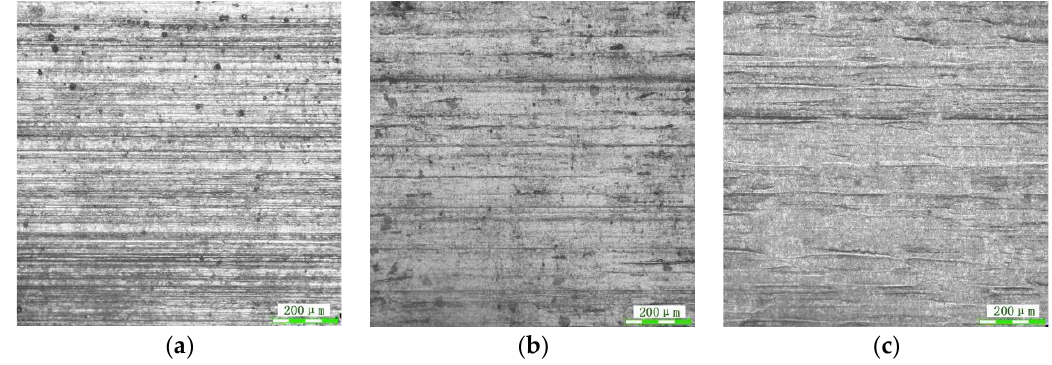
Figure 4. Two-dimensional view of the surface morphology of sample No. 7 (20 × ). ( a ) cutting-in area; ( b ) middle area; ( c ) cutting-out area.